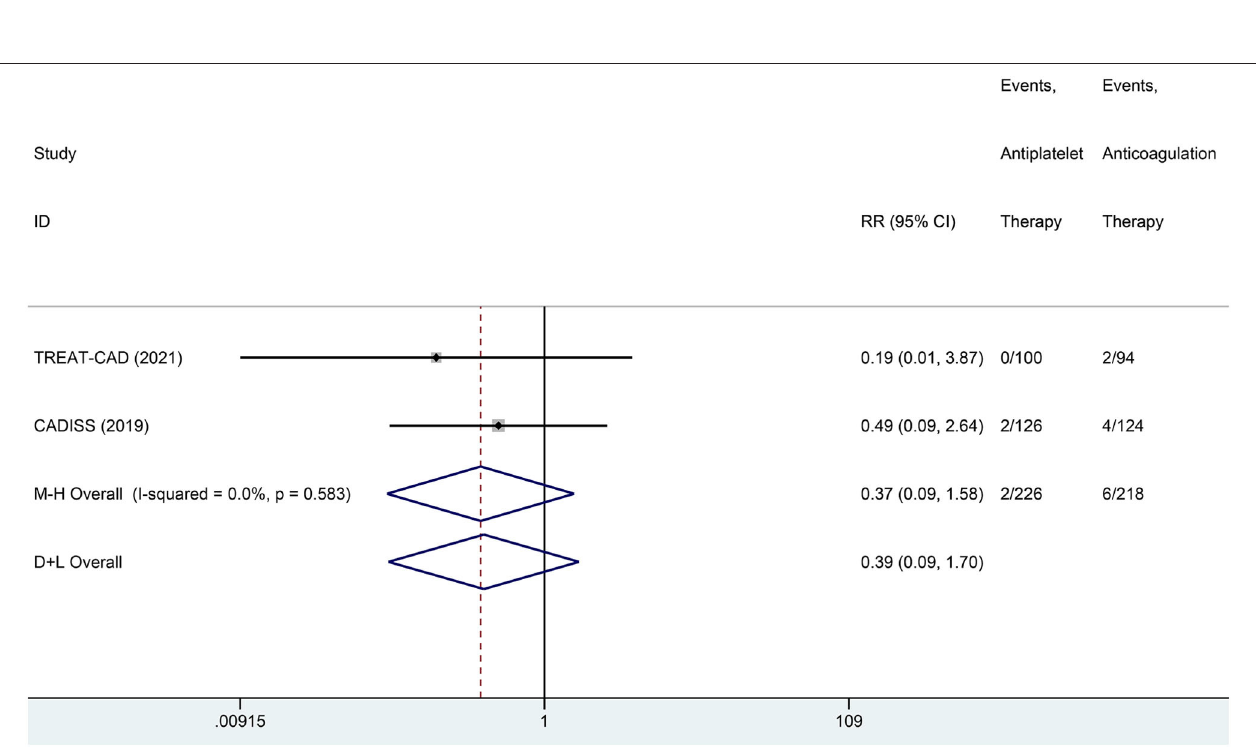
Frontiers in Neurology |